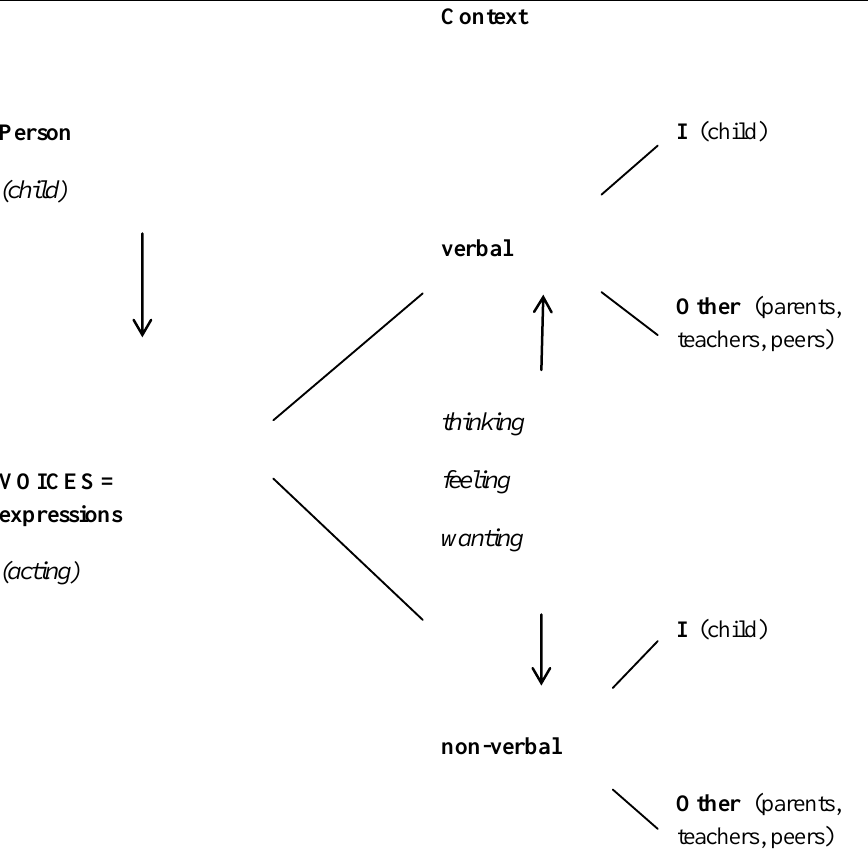
We ground the theoretical framework of our research in the cultural- historical activity